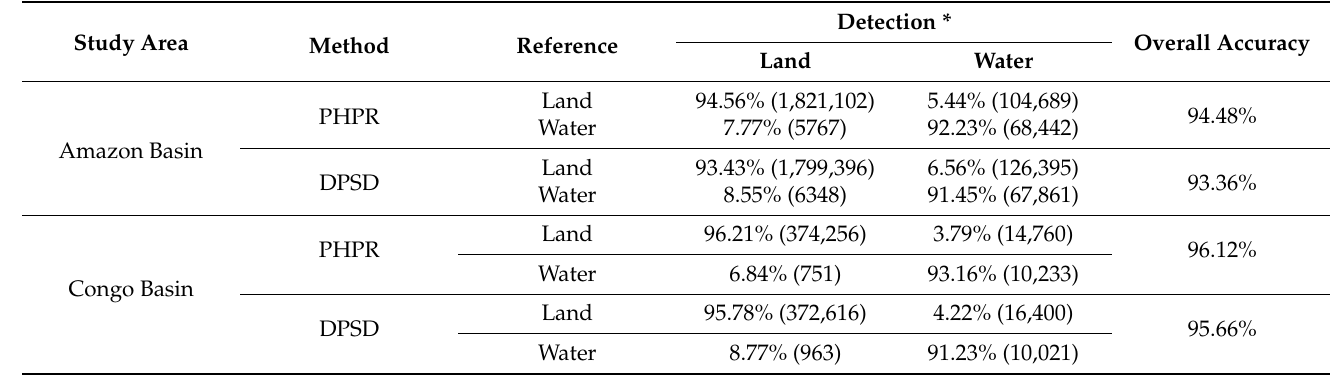
Table 3. Confusion matrices of the two methods and overall accuracies over the Amazon Basin and the Congo